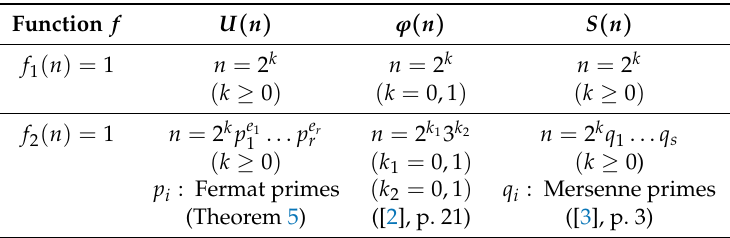
Table 6. ϕ k ( n ) , U k ( n ) , and S k ( n ) with k =